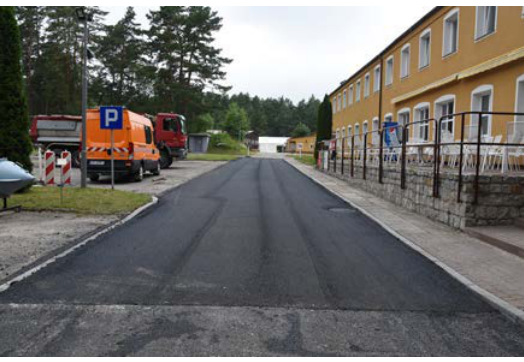
Figure 21. Longitudinal marks caused by paver screed joints on the Dąbrówka trial section.